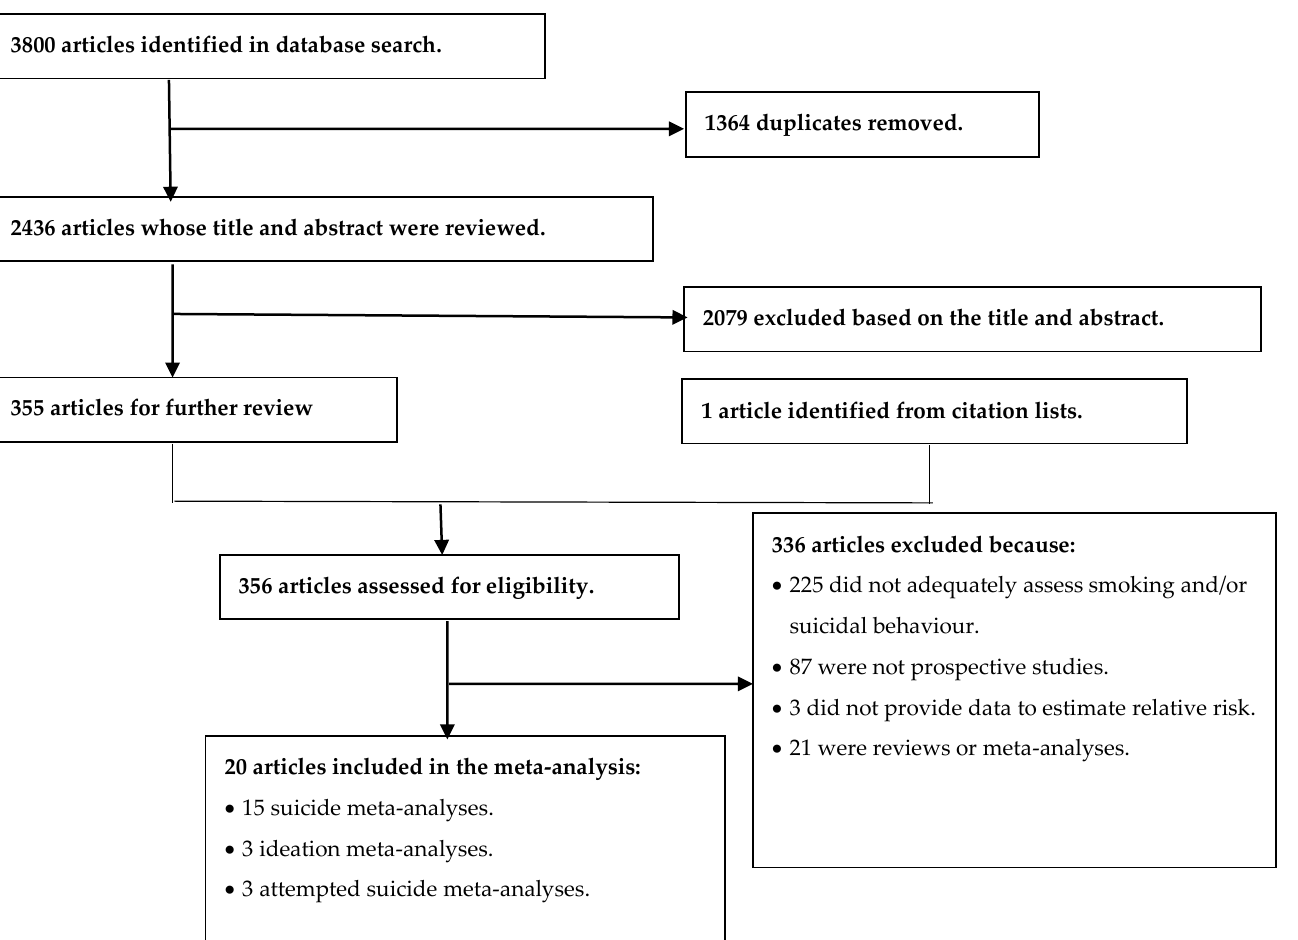
Figure 1. Flowchart of the systematic review process used to select articles for inclusion in this meta-analysis.